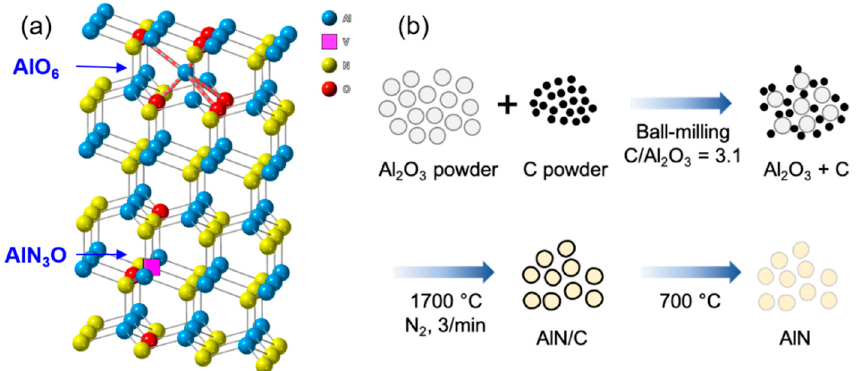
Figure 1. ( a ) Crystal structure of wurtzite-type AlN. 4-coordinated AlN 3 O defect, involving aluminum vacancy (V Al ), and 6-coordinated AlO 6 defect are shown. ( b ) Synthesis of aluminum nitride via carbothermal reaction. Oxygen concentrations of AlN materials were controlled by carbothermal reaction time at 1700 °C. Commercial material from Tokuyama corp. was used as a reference. SEM images of alumina, carbon(C-S/C-L), and aluminum nitride (AlN_C-S, AlN_C-L) are shown in Figure S1.